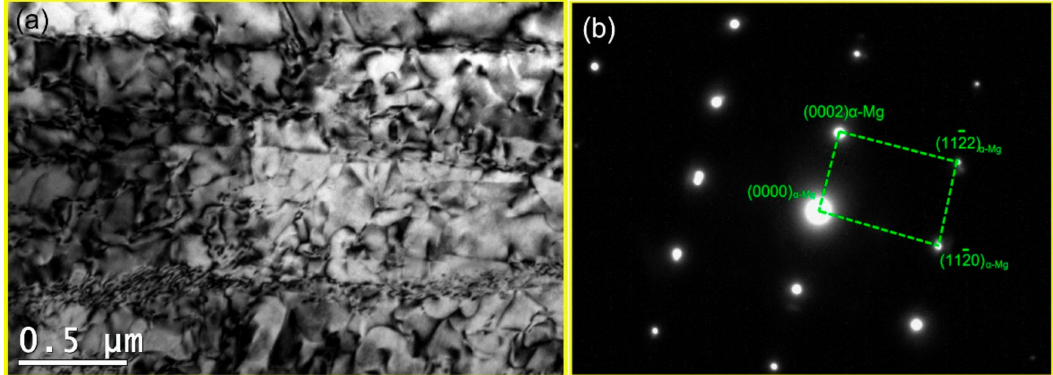
Figure 5. The TEM image of unDRXed region ( a ) and the SAED pattern ( b ).